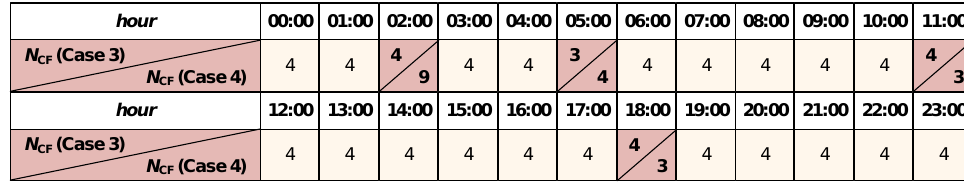
Figure 8. Opened breakpoint indices for different simulation scenarios and constant impedance loading model